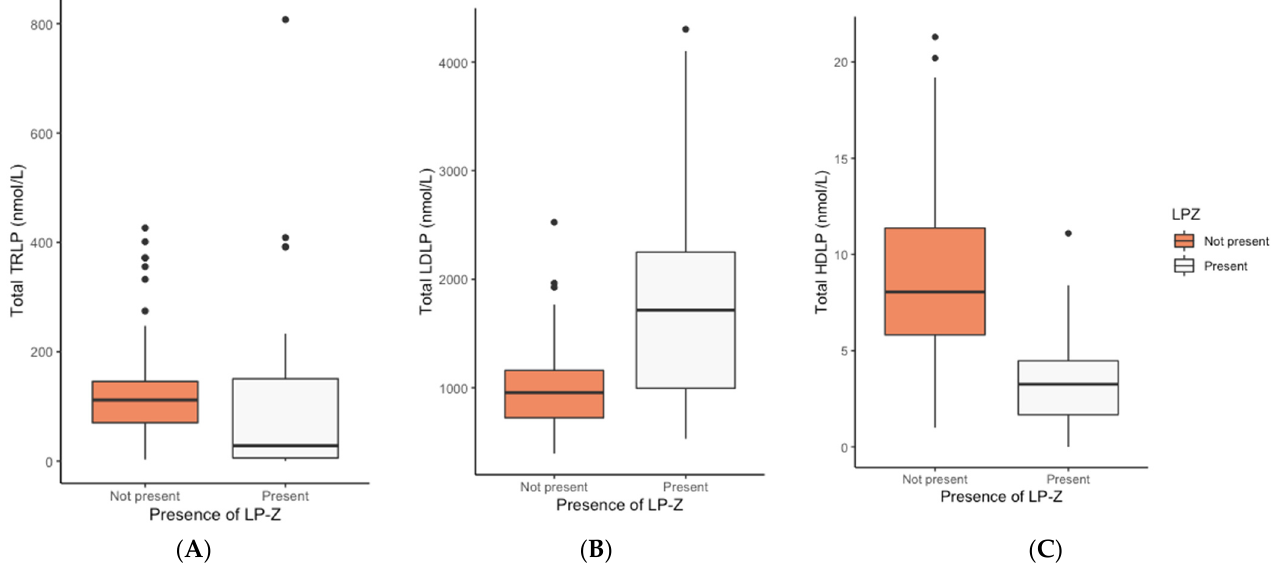
Figure 3. Boxplot of TRLP, LDLP, and HDLP according to presence of LP-Z in pre-transplant cirrhotic group (N = 130). Boxplot ( A ): TRLP, Boxplot ( B ): LDLP, Boxplot ( C ): HDLP. p -values were determined by Mann–Whitney U Test. Abbreviations: HDLP, high density lipoprotein particles; LDLP, low density lipoprotein particles; LP-Z, lipoprotein Z; TRLP, triglyceride-rich lipoprotein particles.